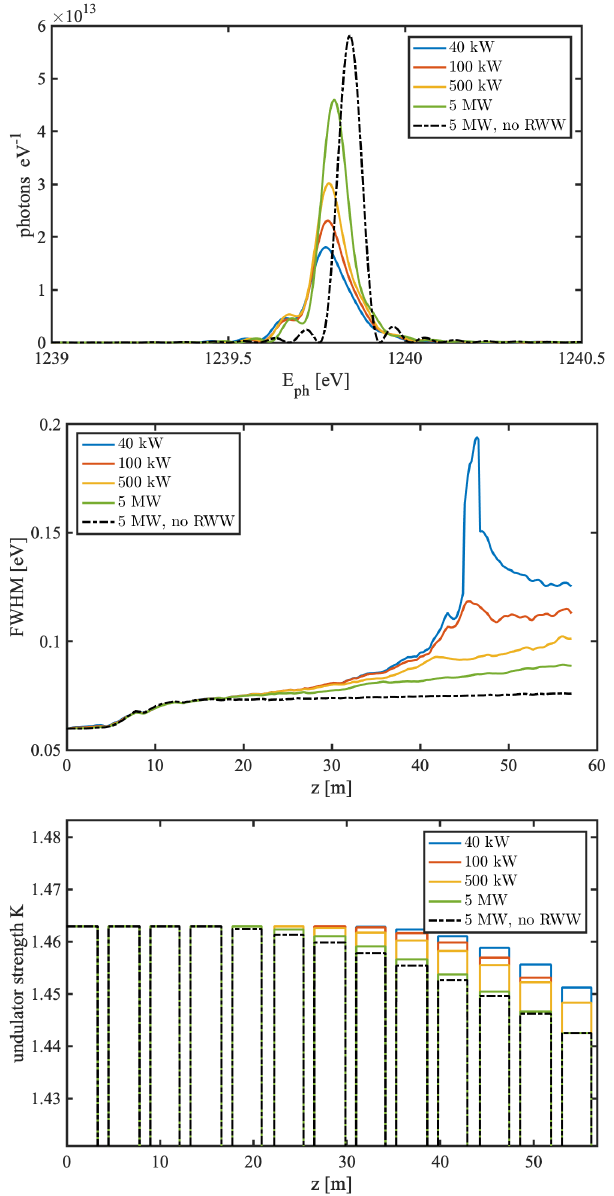
FIG. 8. SXRSS with ideal 50 fs, 1 kA flattop e-beam for different input powers on ideal seeds. Top: final spectra, Middle: bandwidth evolution, Bottom: optimized taper